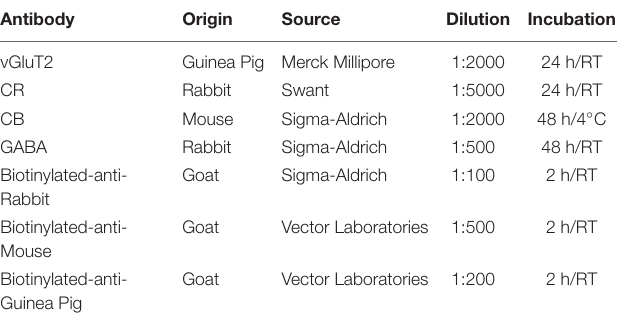
TABLE 1 | Antibodies used in the study. Antibody